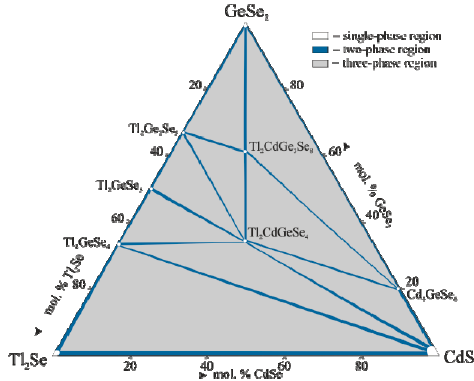
Figure 1. Isothermal section of the quasi-ternary system Tl 2 Se–CdSe–GeSe 2 at 570 K